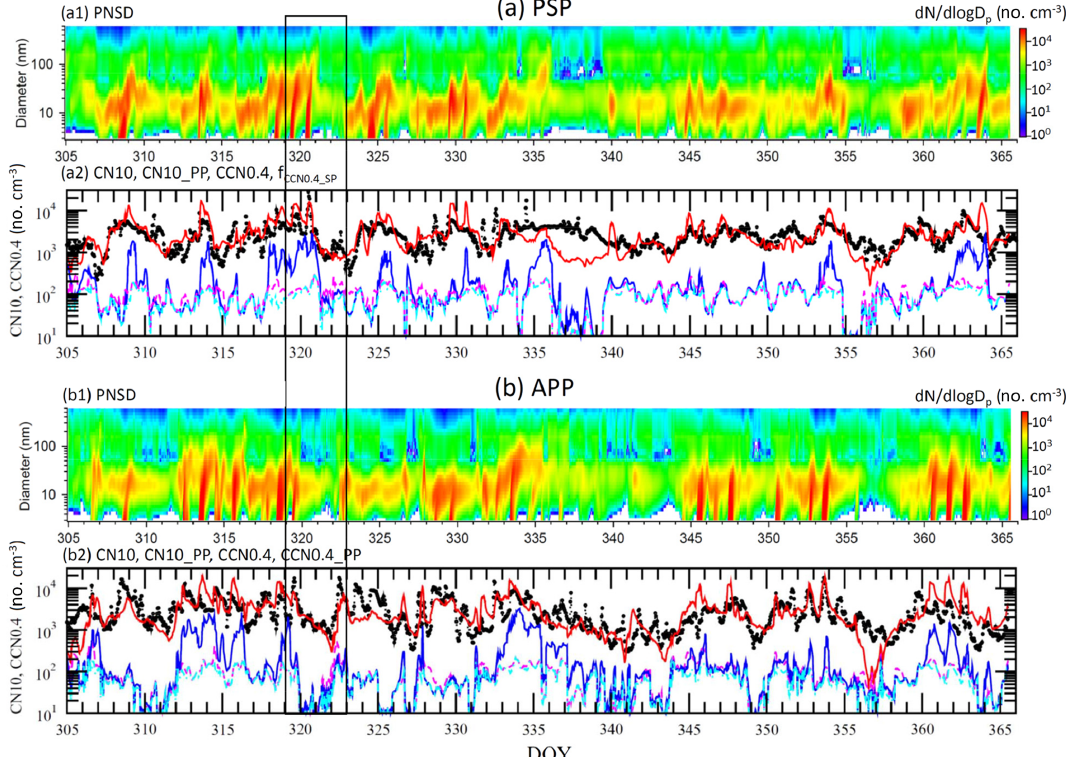
Figure 3. For the (a) PSP and (b) APP sites in the NEUS: modeled wintertime (November–December 2013) evolution of particle number size distributions (PNSDs; a1, b1 ) and time series (a2, b2) of CN10 (red line), CN10 due to primary particles (CN10_PP; dashed magenta line), CCN0.4 (blue line), and CCN0.4 due to primary particles (CCN0.4_PP; dashed cyan line). In panels (a2) and (b2) , CN10 values from observations (black circles) are also shown for comparison. The model results are for the model surface layer ( ∼ 0–100m above surface). Selected 4d period from 15–18 November 2013 with nucleation events and nonevents is marked with a black